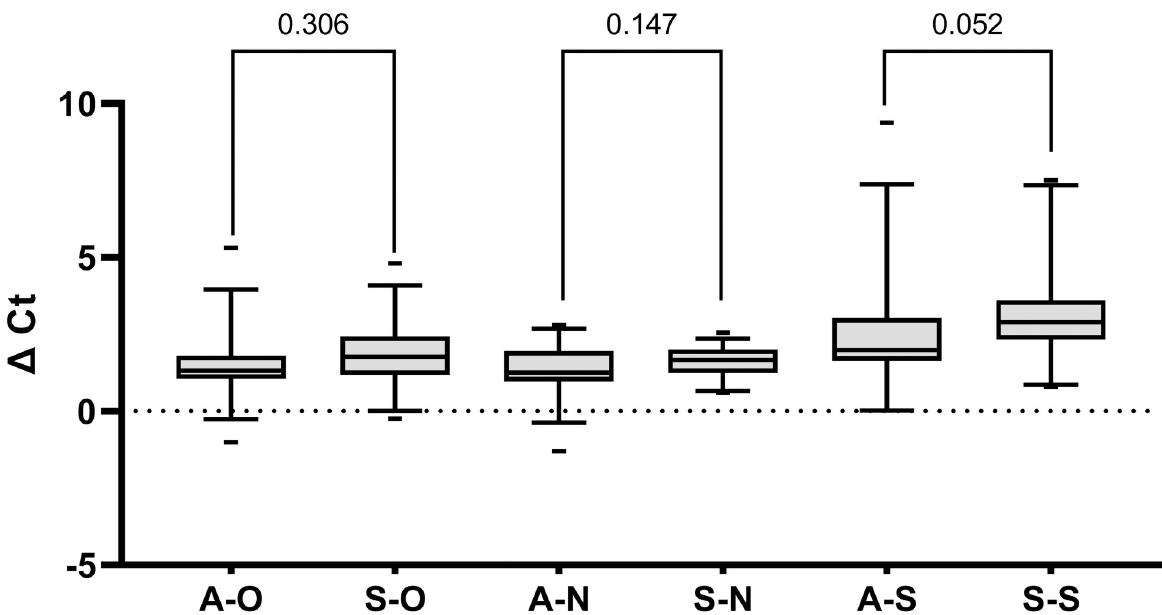
Fig 2. Asymptomatic and symptomatic C t shift. Box-and-whisker plot describing C t shift ( Δ C t ) for each gene from each cohort; whiskers, 5–95 percentiles; min-max range, dash mark; p-values annotated; A, Asymptomatic; S, Symptomatic; O, ORF1ab gene; N, N gene; S, S gene.